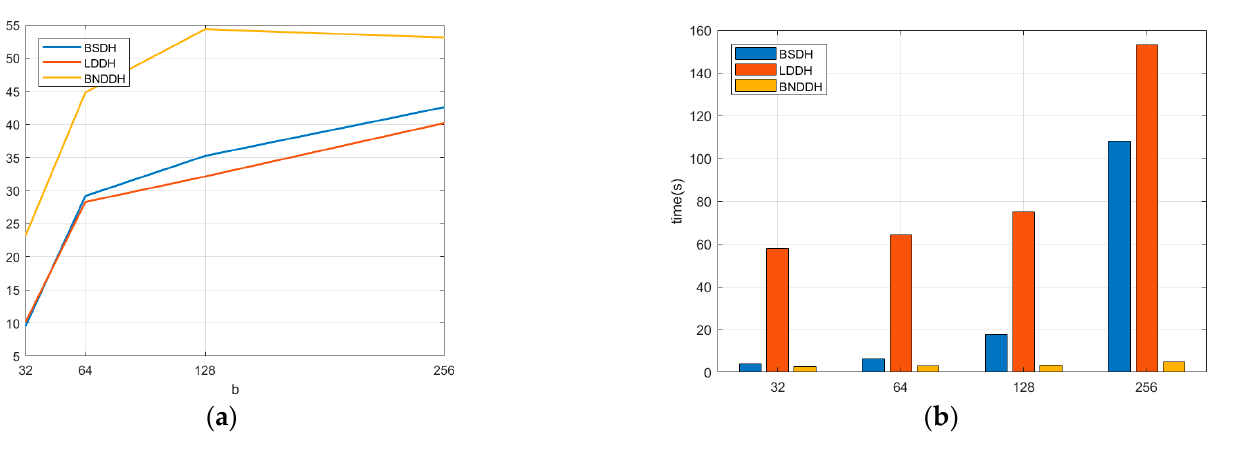
Figure 9. MAP and training time on the AR database ( a ) MAP ( b ) training time.